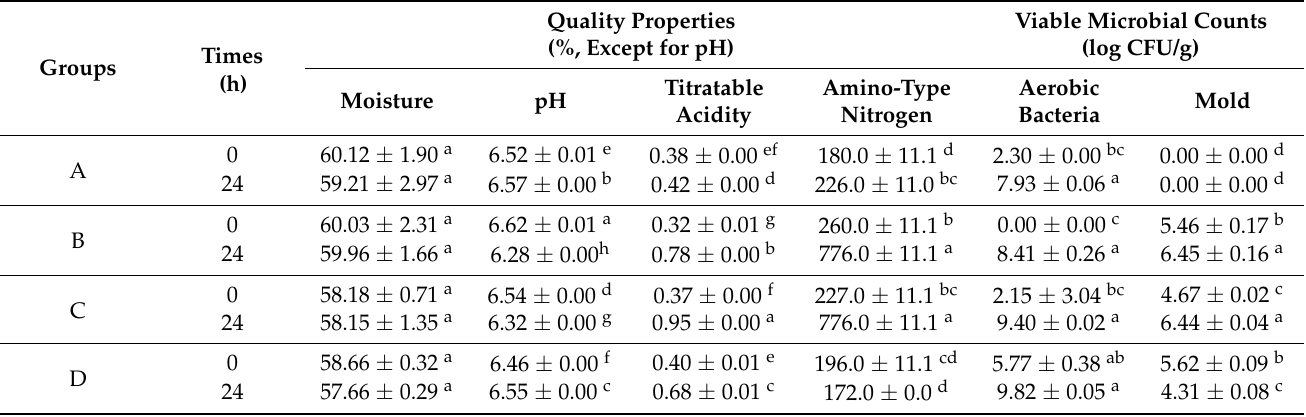
Table 1. Changes in moisture, pH, titratable acidity (%), amino-type nitrogen (mg%), and viable microbial counts in Meju